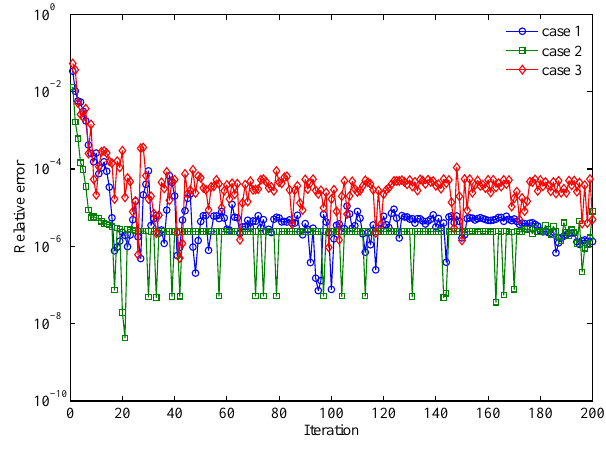
Figure 1. Evolution of the relative error with respect to the iteration number.